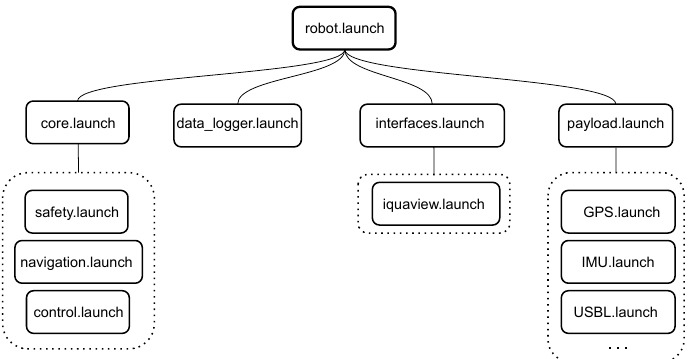
Figure 4. Principal architecture launch